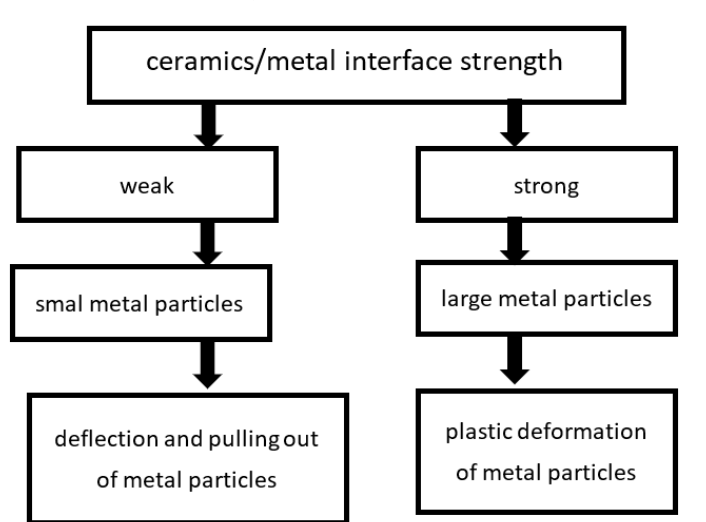
Figure 8. Diagram showing relationship between ceramics/metal interface strength and mechanism of fracture toughness improvement. of fracture toughness